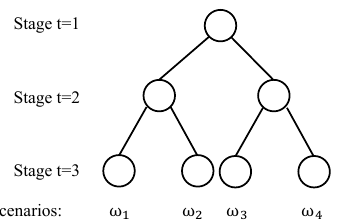
Figure 2. The scenario tree for a three-stage stochastic program with two realizations per